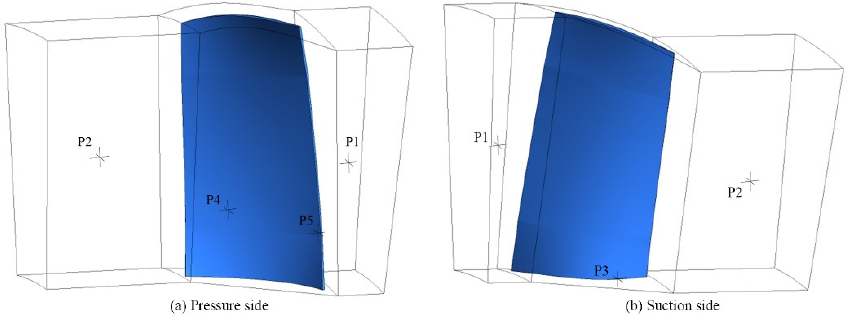
Figure 9. Location of measurement points. ( a ) Pressure side; ( b ) Suction side.